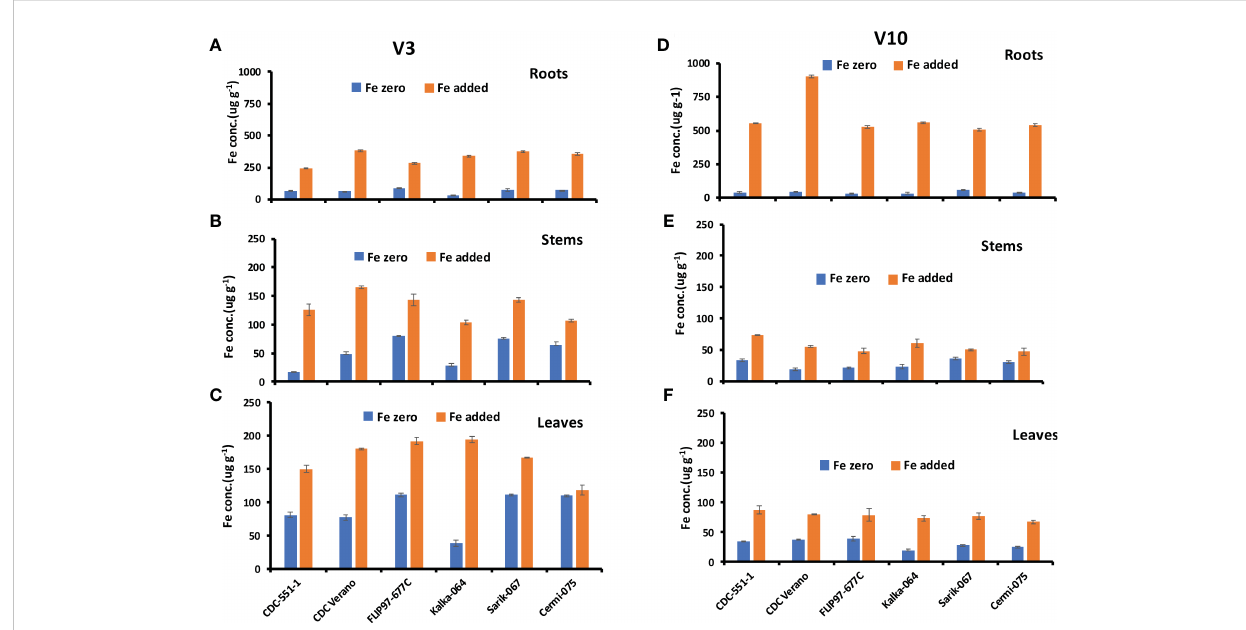
FIGURE 2 Mean Fe concentration (µg g -1 , ± SE, n = 48) at V3 and mean Fe concentration (µg g -1 , ± SE, n = 24) at V10 growth stages in roots (A, D) , stems (B, E) , and leaves (C, F) of six different genotypes of chickpea under Fe zero and Fe added